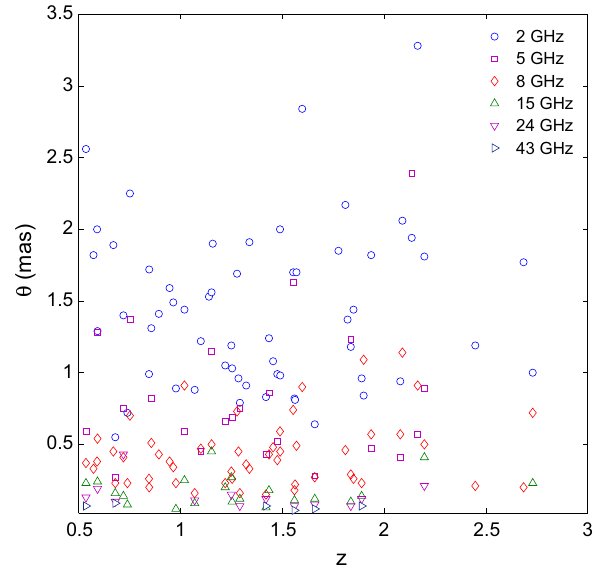
Fig. 1 Angular size vs. redshift for the Pushkarev and Kovalev [31] sample of 58 sources at six radio